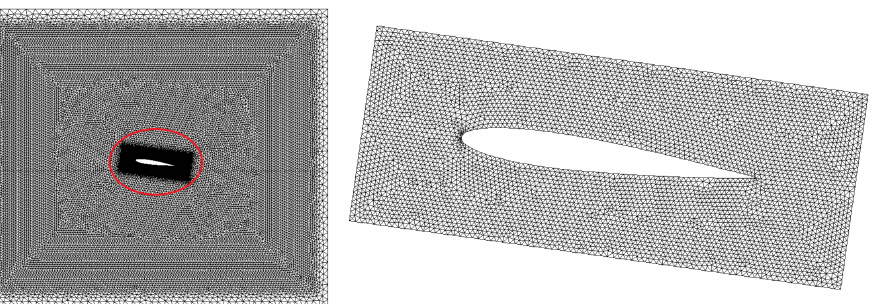
Figure 4. Computational domain and mesh: 34,360 elements and 131,720 nodes ( left ). Mesh subdo- main around the hydrofoil ( right ).